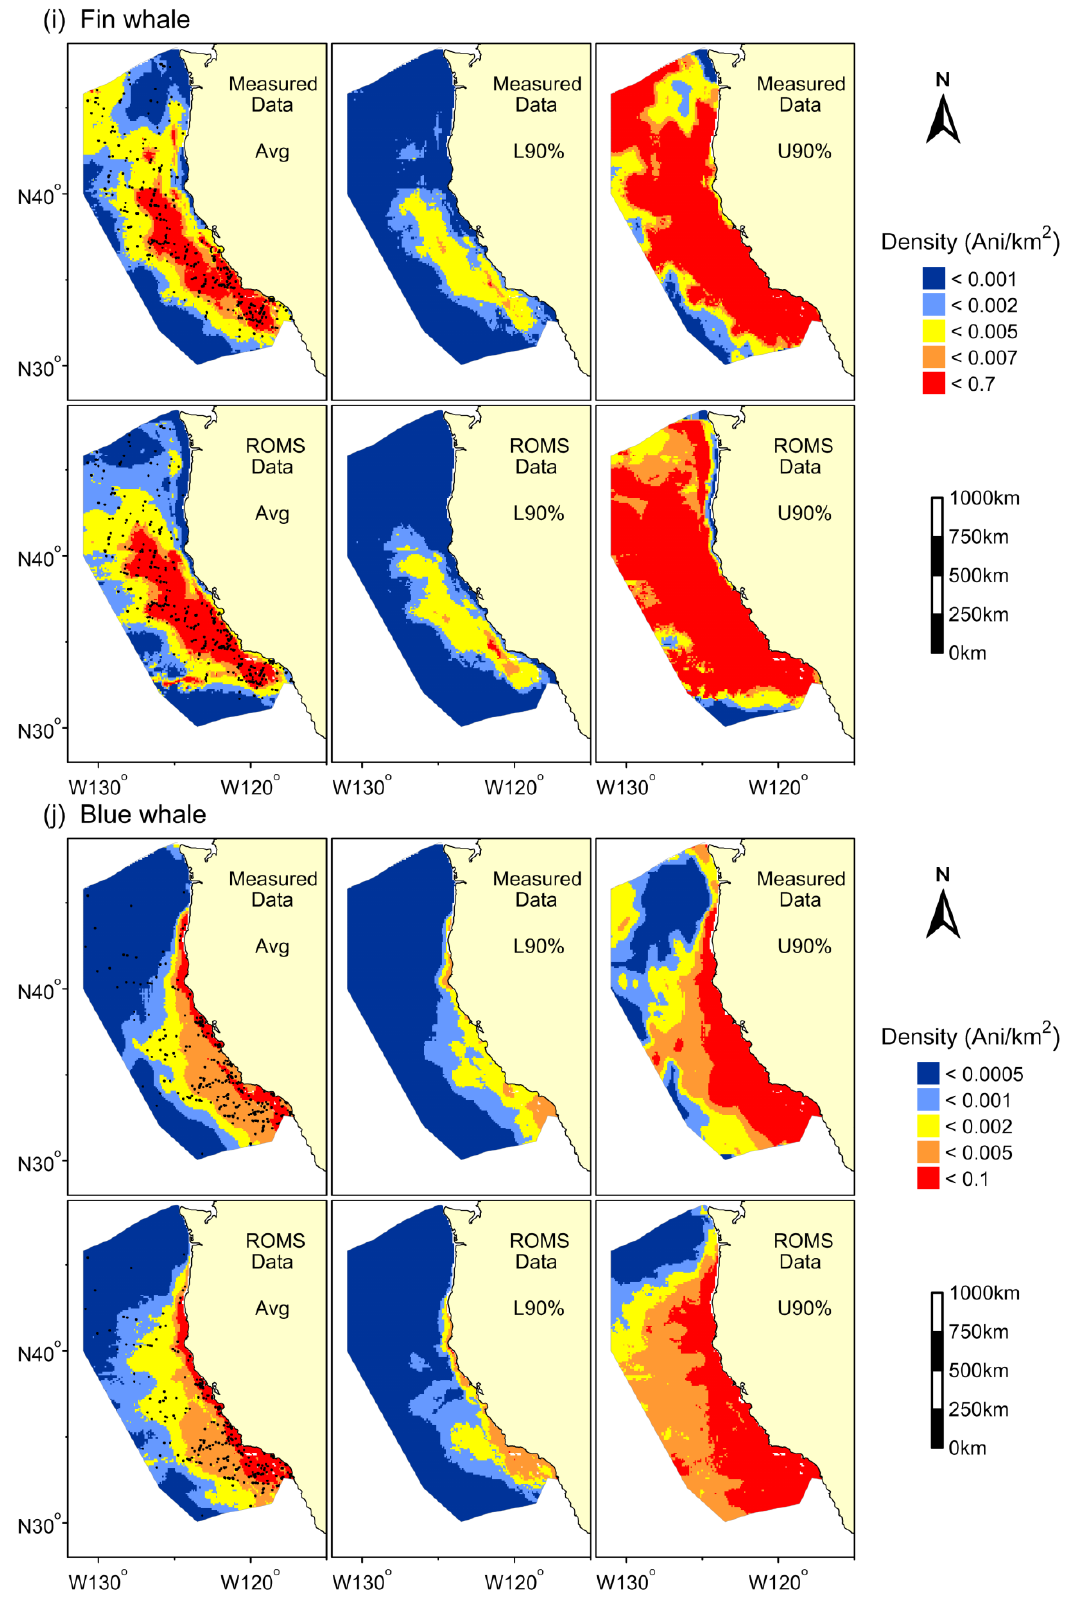
Figure 2. Cont. Figure 2.